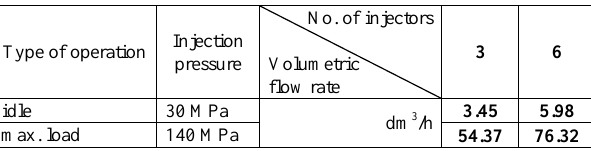
Table 4. Required high-pressure pump volumetric flow